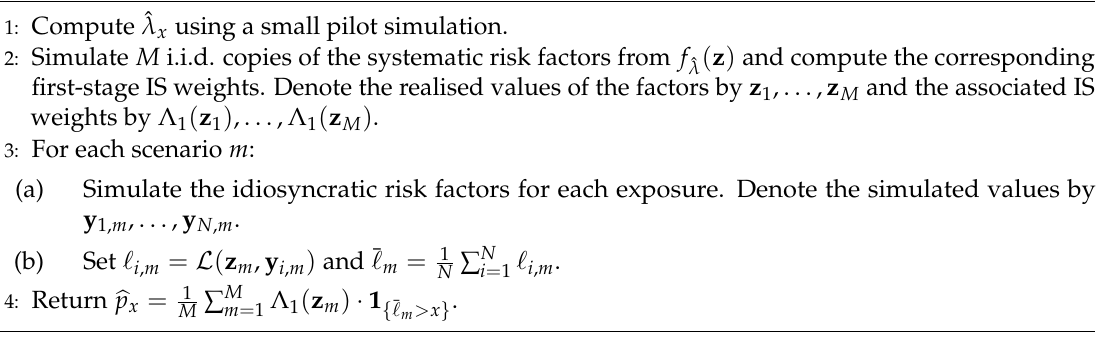
Algorithm 4 Proposed One-Stage IS Algorithm for Estimating p